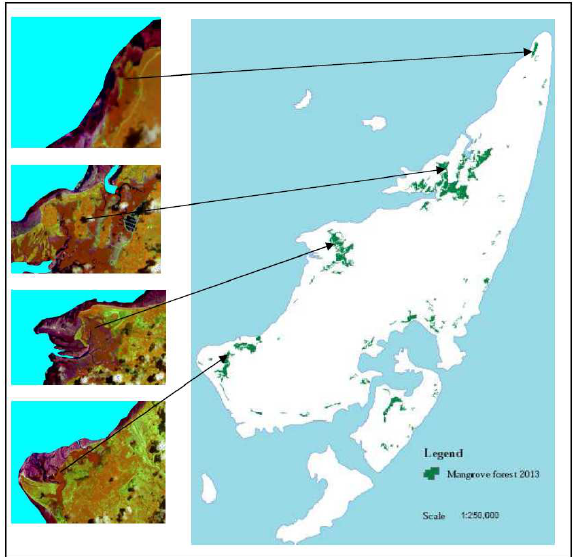
Figure 5. Sections of colour composite of mangrove rich areas in Mafia Island and the final output map of classified images showing distribution of mangrove in the year 2013